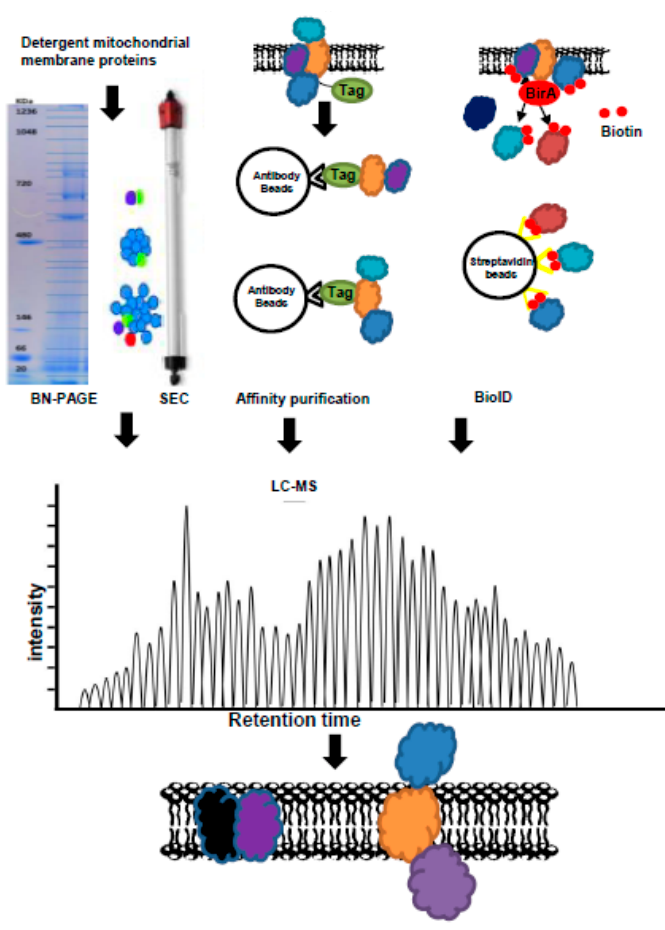
Figure 2. Methods used for protein–protein interaction combined with liquid chromatography–mass spectrometry (LC-MS). BN-PAGE: Blue native polyacrylaminde gel electrophoresis, SEC: Size exclusion chromatography, BioID: proximity-dependent biotin identification.